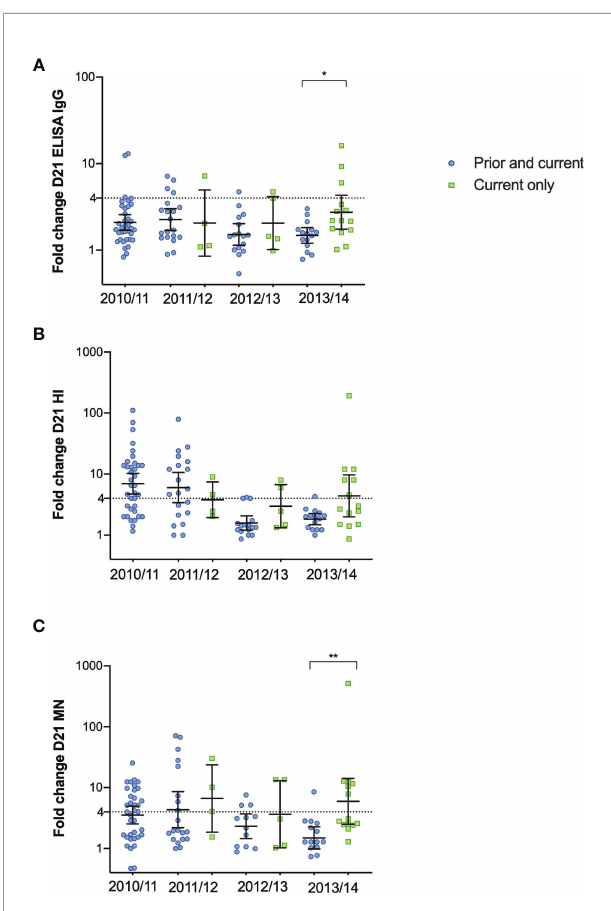
FIGURE 3 | The fold change after vaccination in 2010/11 – 2013/14 in HCW receiving the prior and current vaccination and the current vaccination only. The fold-change from pre-vaccination titres (D0) to post-vaccination titres (D21) measured in ELISA (A) , HI (B) and MN titres (C) in the HCW with the current vaccination only and those with the prior and current vaccination. Each symbol represents an individual ELISA, HI and MN fold change. The horizontal line shows the geometric mean with 95% con fi dence interval, and the dotted line at 4 indicates seroconversion. Statistical differences between the groups were tested with the Kruskal-Wallis test, with Dunn´s multiple comparisons test. **P < 0.01, *P <